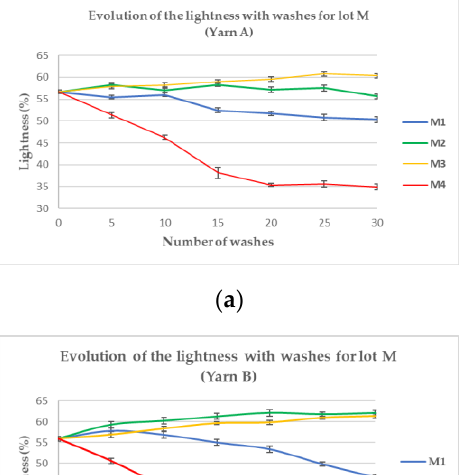
Figure 6. Evolution of the lightness with washes from Lot S, Yarns A ( a ), B ( b ) and C ( c ).